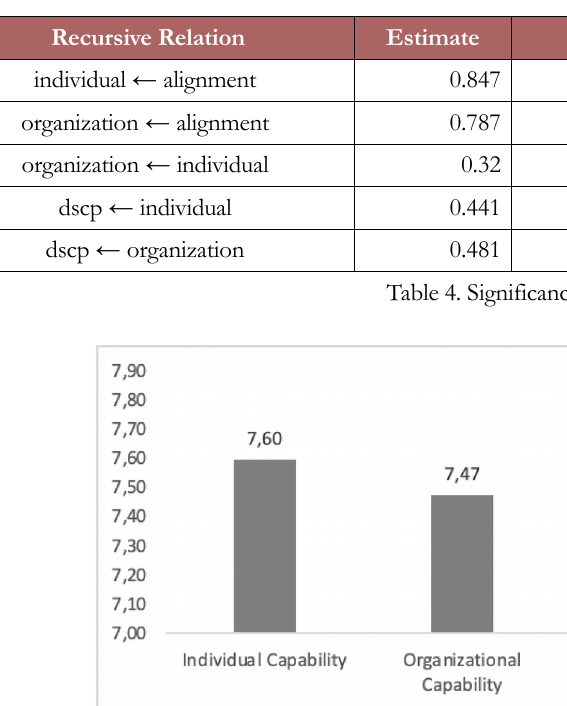
Figure 5. Maturity Mapping Result on Latent